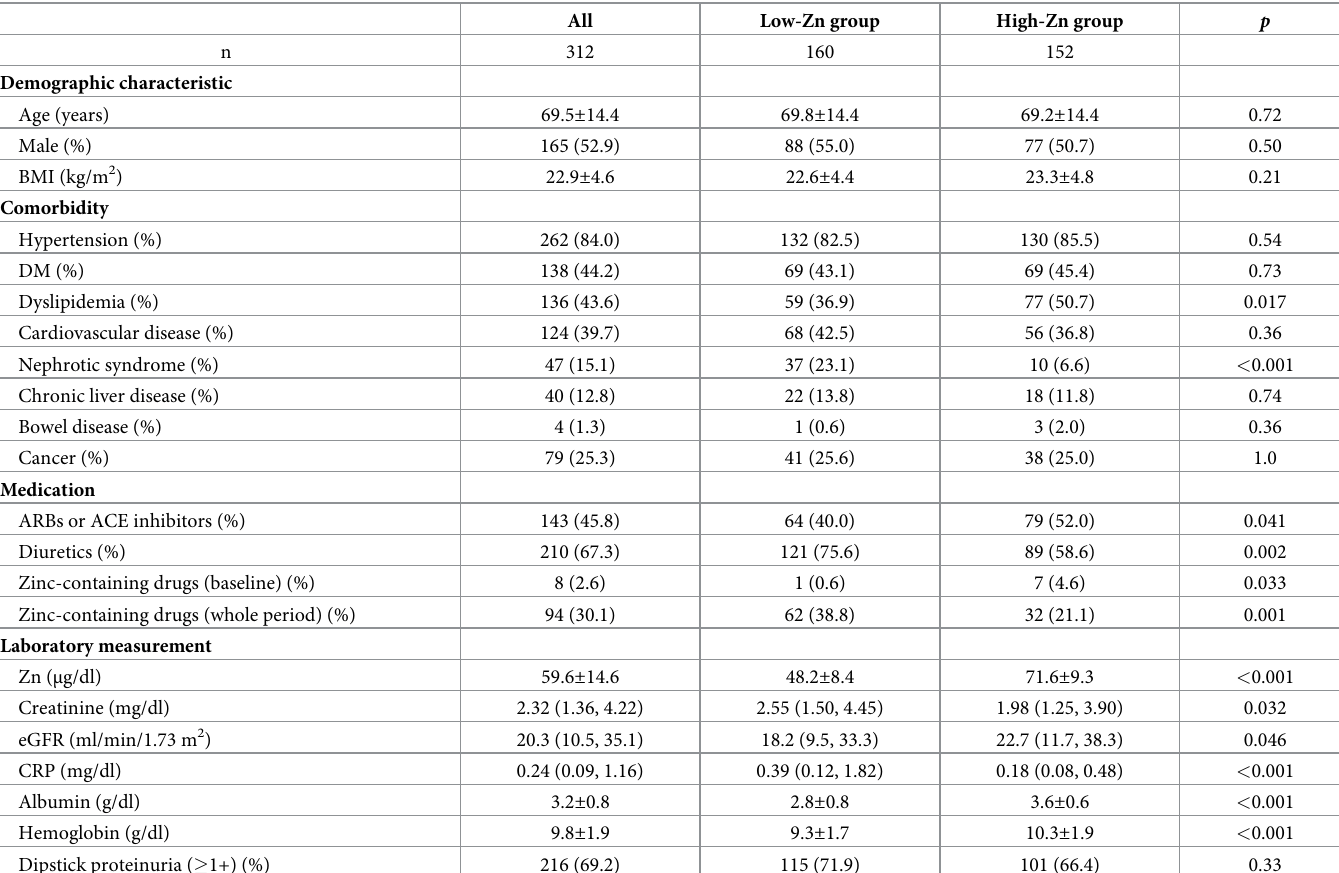
Table 1. Baseline characteristics of patients grouped by Zn levels.